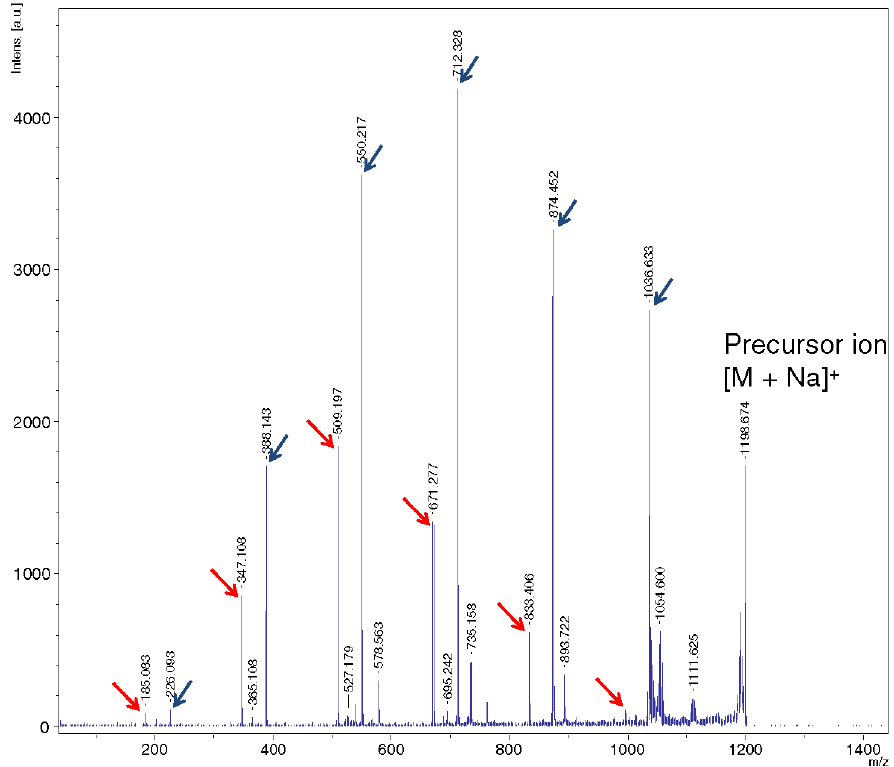
Figure 9. LID MALDI TOF / TOF MS of the [M + Na] + ion generated from 7 . Peaks of NHAc-containing ions are marked by blue arrows, and red arrows show peaks of ions with no nitrogen (reproduced from [55], Open Access material under the Creative Commons license).